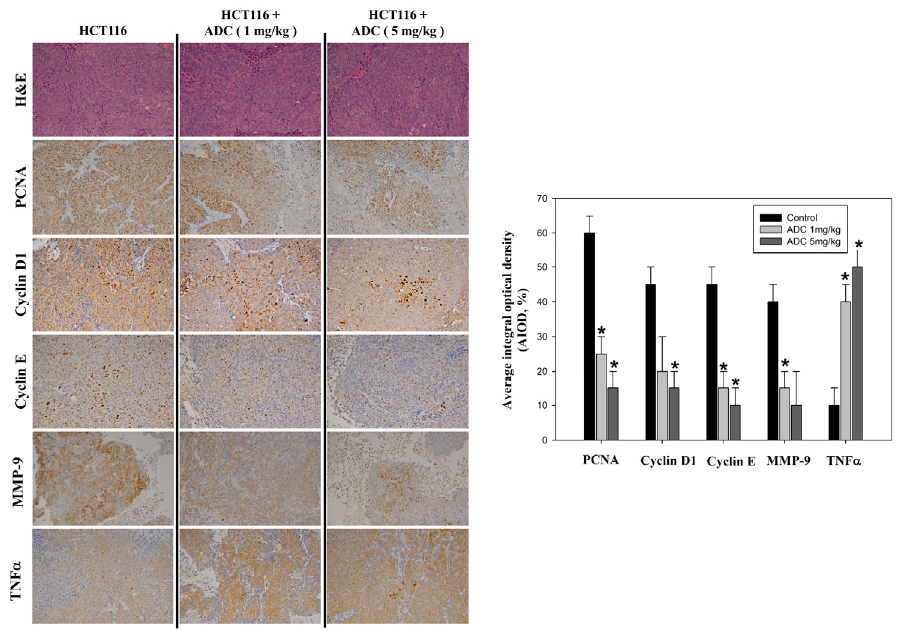
Figure 5. Antrodin C (ADC) varies proliferative and apoptotic protein expression in CRC cells in an in vivo xenograft mouse model. Hematoxylin and eosin staining of the tumors of the nude mice was performed (1st row, upper panel). Protein levels of PCNA (2nd row, upper panel), cyclin D1 (3rd row, upper panel), cyclin E (5th row, upper panel), MMP-9 (6th row, upper panel), and TNF α (7th row, upper panel) were detected by using immunohistochemical analysis. Right panel: By calculating the average of integrated optical density (AIOD), quantitative assay of PCNA, cyclin D1, cyclin E, MMP-9, and TNF α proteins was evaluated. Multiple tumor fields and their positively stained area were evaluated and then evaluated by randomly selecting three observational fields of each section (n = 6/group). The data are expressed as mean ± SD. * p < 0.05, magnification ×200.